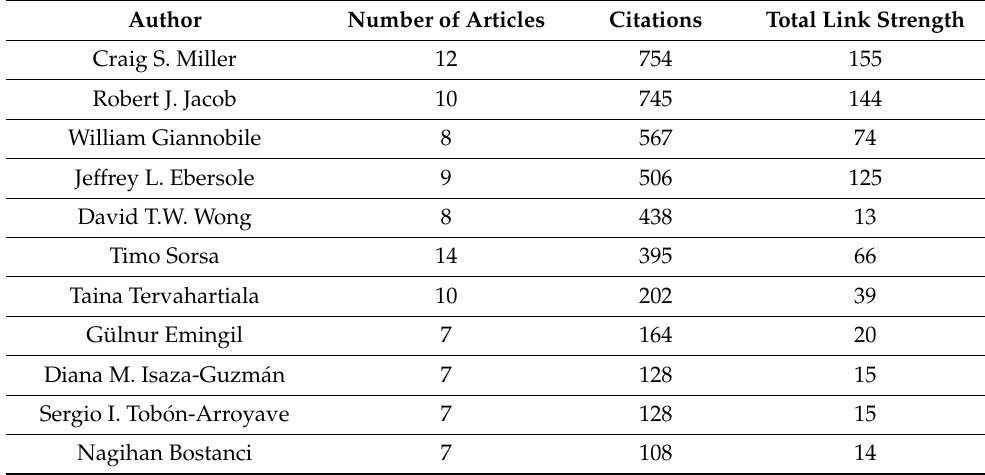
Table 4. Identifying leading authors who published papers related to salivary